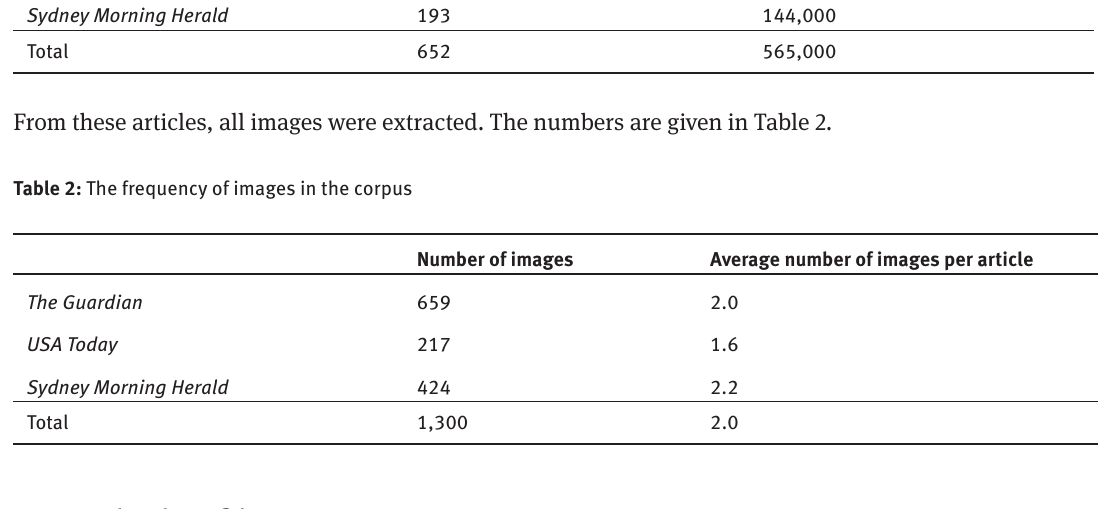
Number of relevant articles Number of words